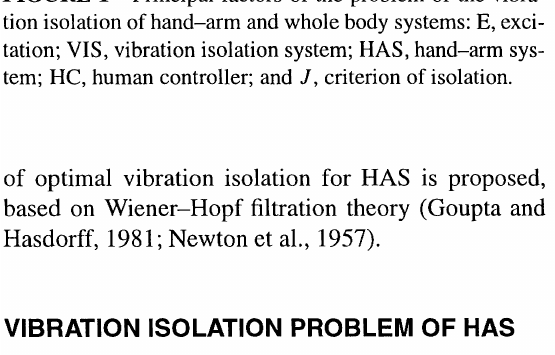
FIGURE 2 Dynamical structure of the 1.5-DOF bent hand-arm model.